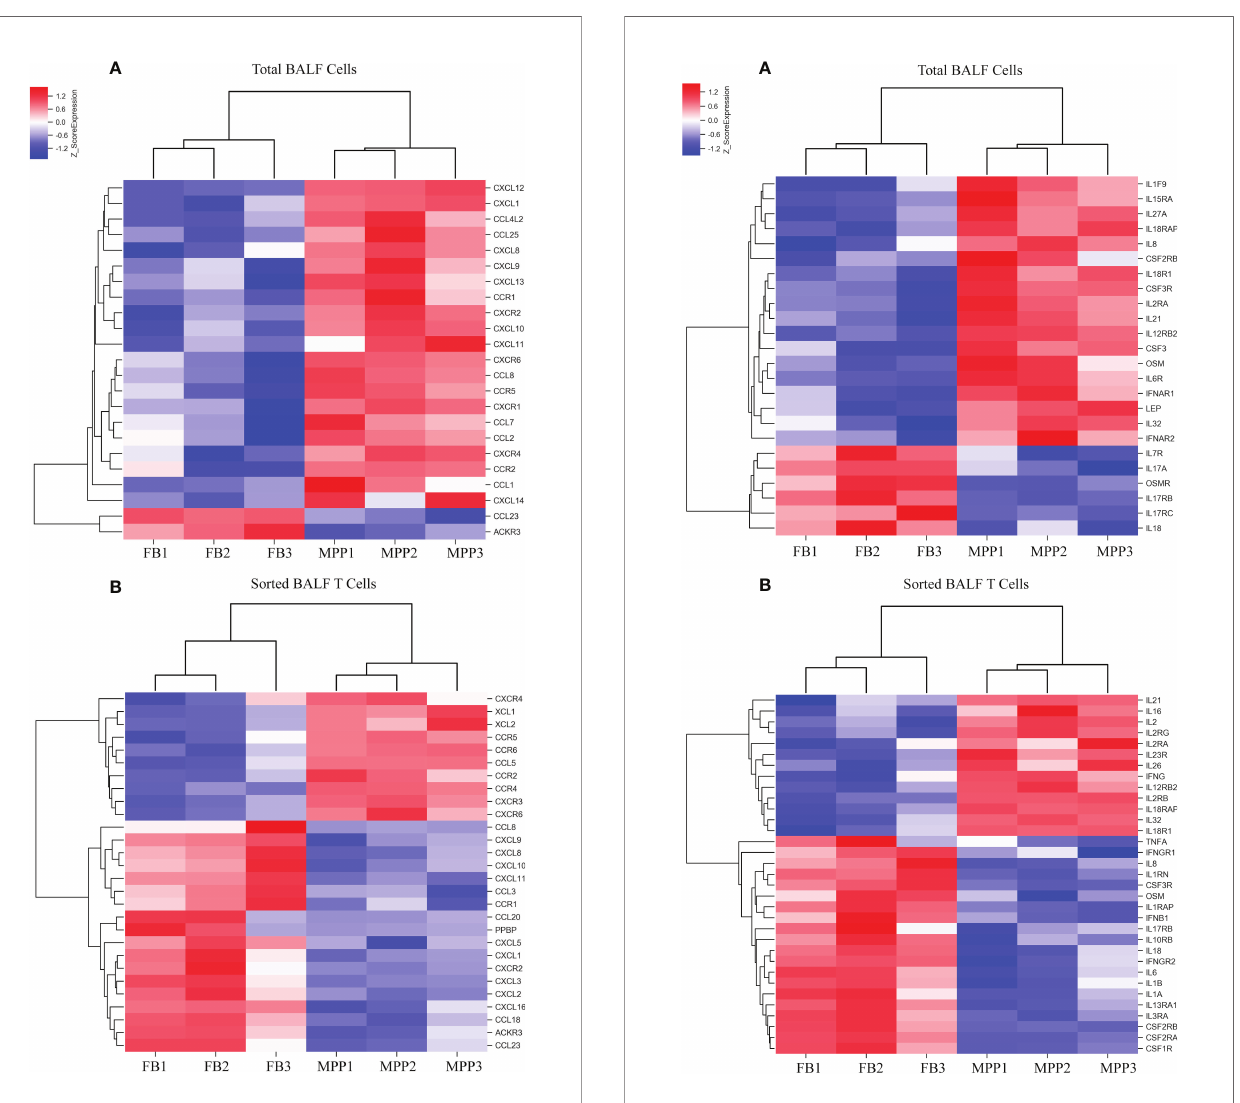
FIGURE 5 | DEGs of cytokines from microarray results were represented as heat maps. Colors indicate relative expression levels. The gradient color from red to blue means expression of the listed gene from upregulation to downregulation. Gene names of DEGs are listed on the right. Similar pattern of expression are clustered closer with linked line. (A) The heat map for DEGs of cytokine gene in BALF cells. Each sample represents BALF cells from an individual patient or FB control. (B) The heat map for DEGs of cytokine gene in sorted CD3+ T cells. Each sample represents CD3+-sorted cells from an individual patient or FB